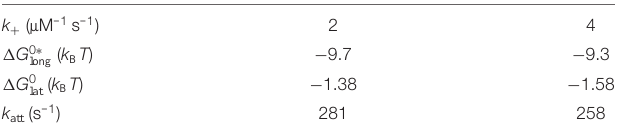
TABLE 3 | Growth parameter values that generate the most linear dependence v gro ( c tub